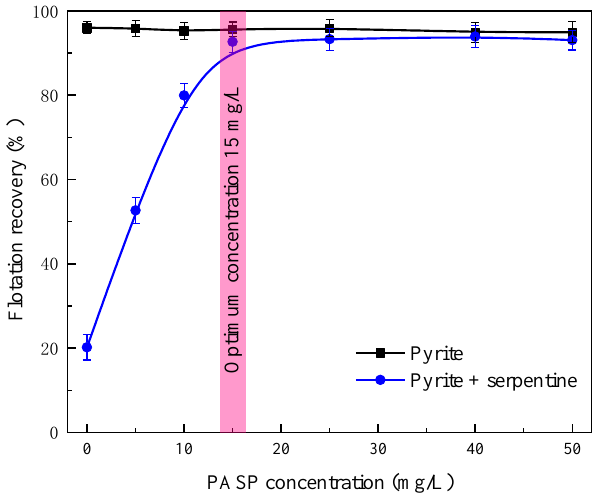
Figure 5. Effect of PASP on the flotation recovery of pyr ite without and with serpentine (−10 µm) as a function of PASP concentration (pH = 9, [serpentine] = 5 g/L).